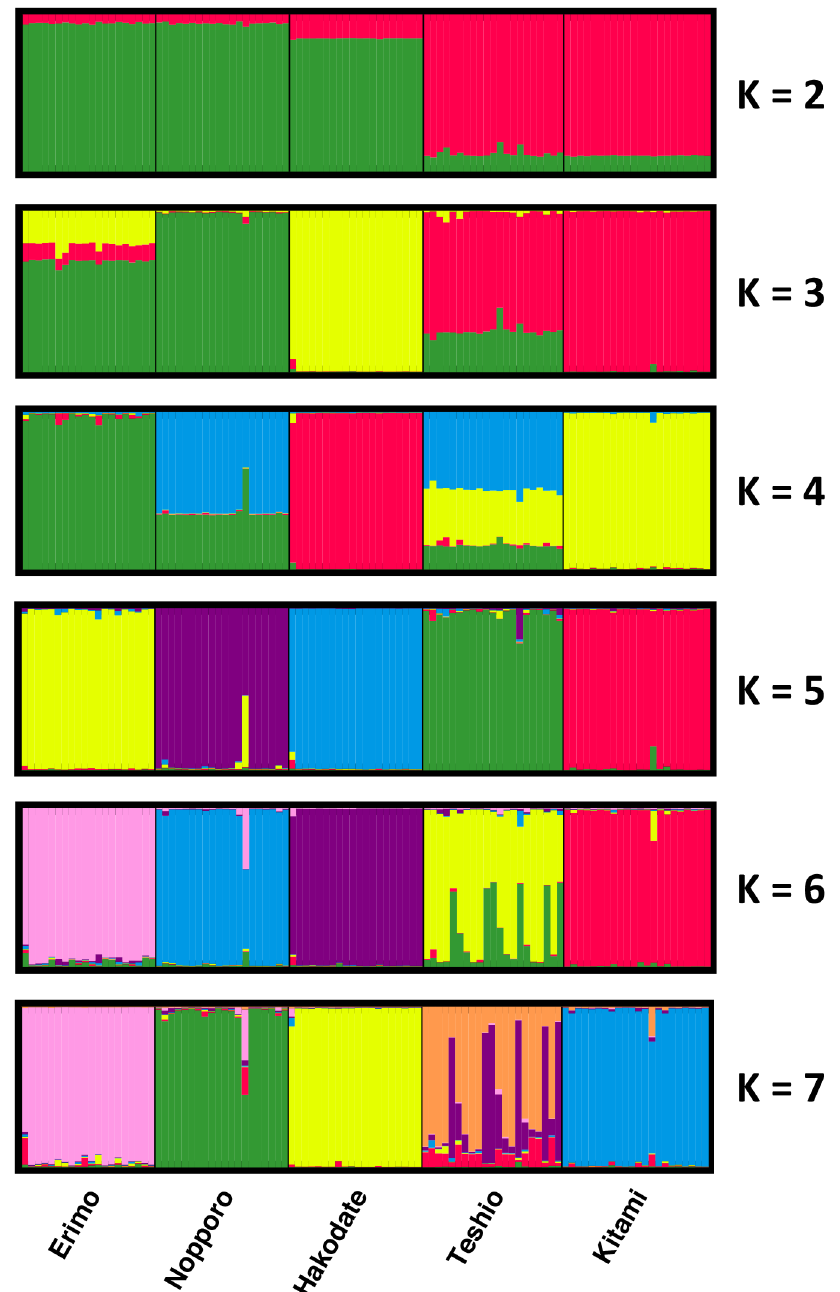
Fig 3. Assigned genetic clusters of the five local populations. Structure analysis was conducted for different K values ( K = 2 – 6). The population structure was optimal (based on Δ K ) for K = 5.